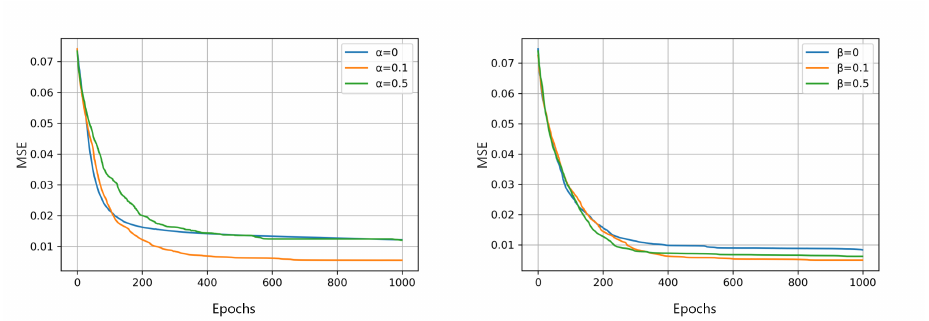
Figure 6. The variety of average MSE test error with the increasing of epochs using 1000 plant seedling images. The influences of α ( left ) and β ( right ) in Equation (9) are